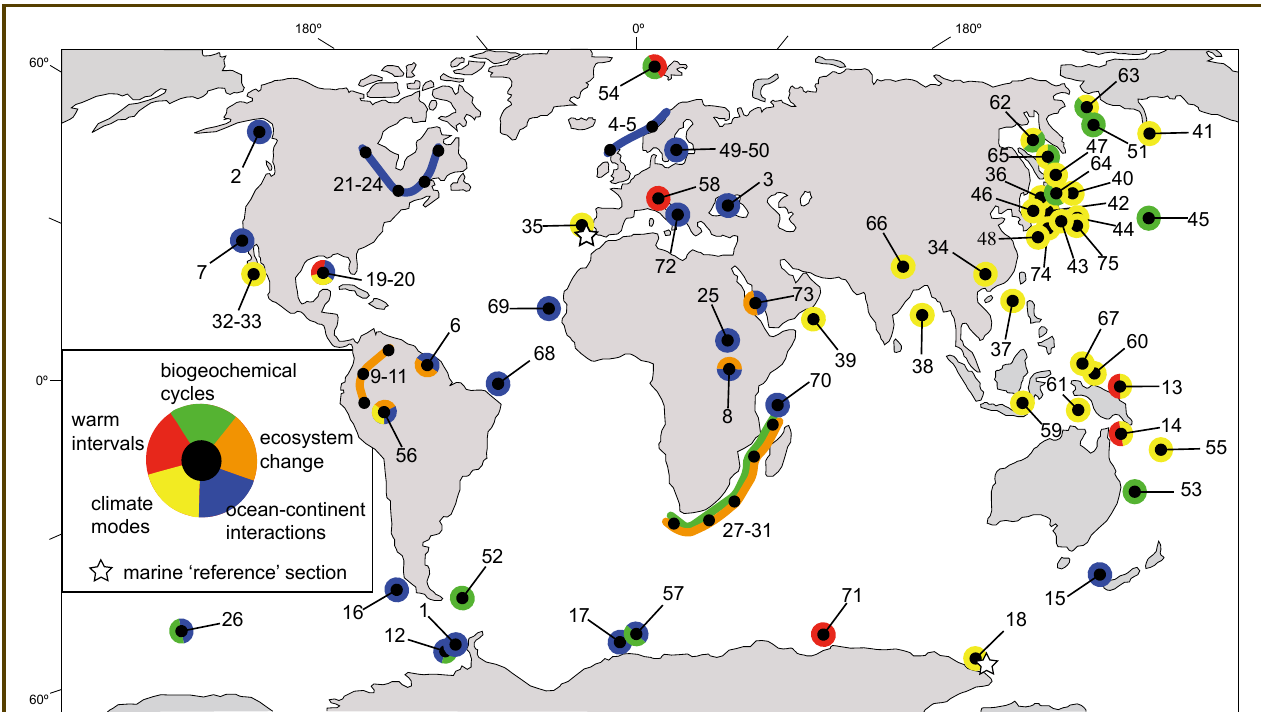
Figure 1. Compilation of potential drilling sites proposed by workshop participants to address the scientific themes ‘Warm intervals through time’, ‘Ocean-continent interactions’, ‘Biogeochemical cycles’, ‘Ecosystem change’, and ‘Climate modes’; from Thurow et al., (2009). Site numbers are linked to information that can be found in Appendix 1 at